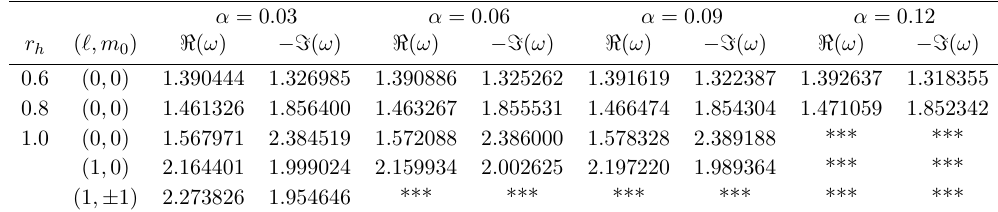
Table 5 . Subdominant oscillatory quasinormal modes of the ARNAdS black holes of table